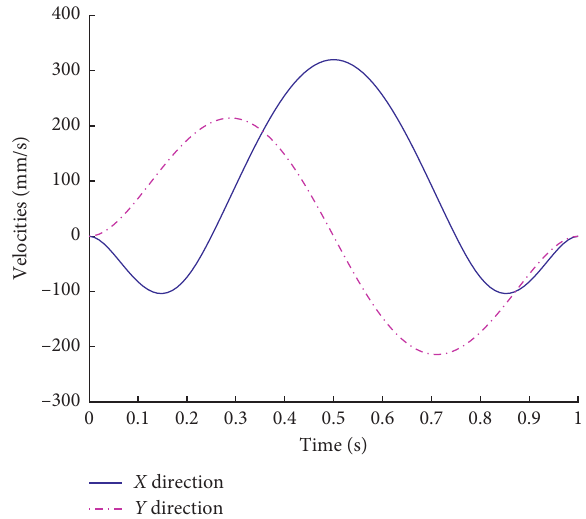
Figure 4: Velocity curve of submovement of trajectory.